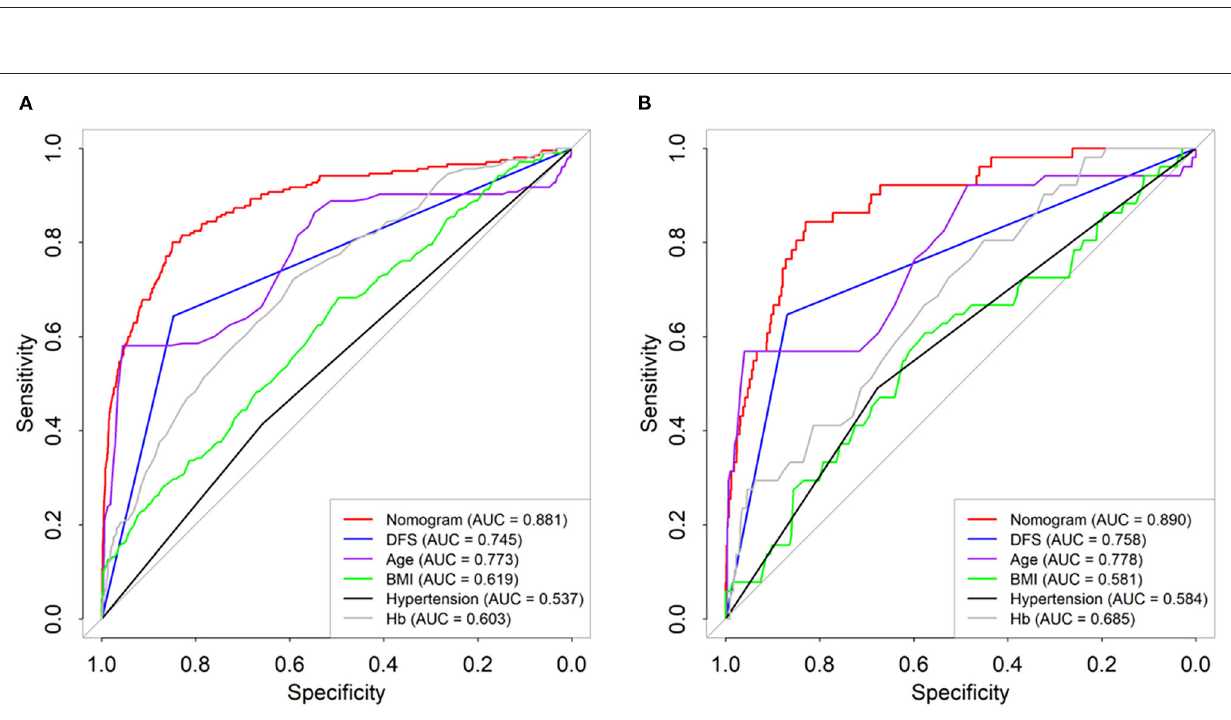
Frontiers in Surgery |